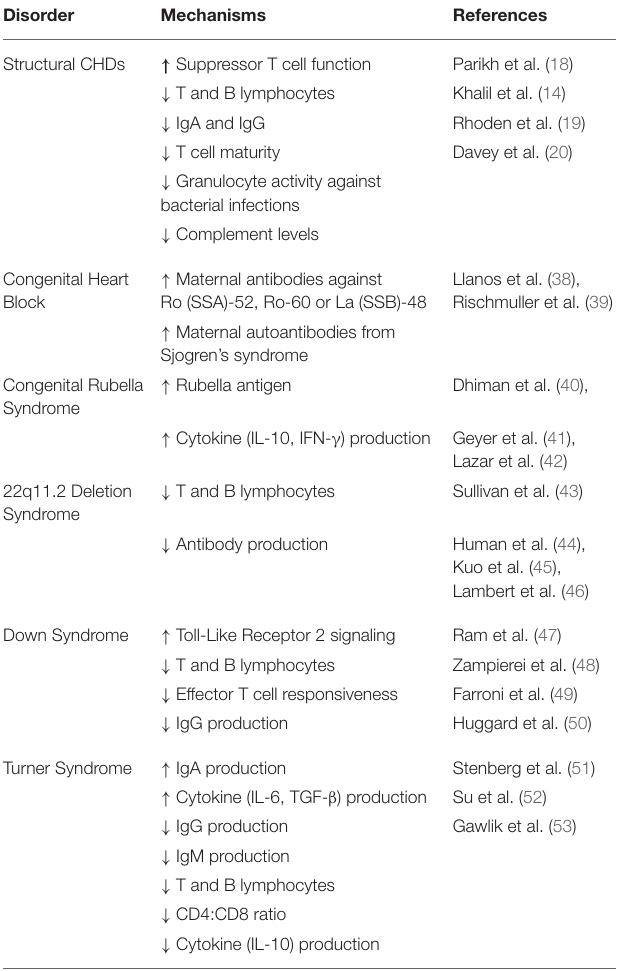
TABLE 1 | Immune and inflammatory markers associated with congenital heart disease. Disorder